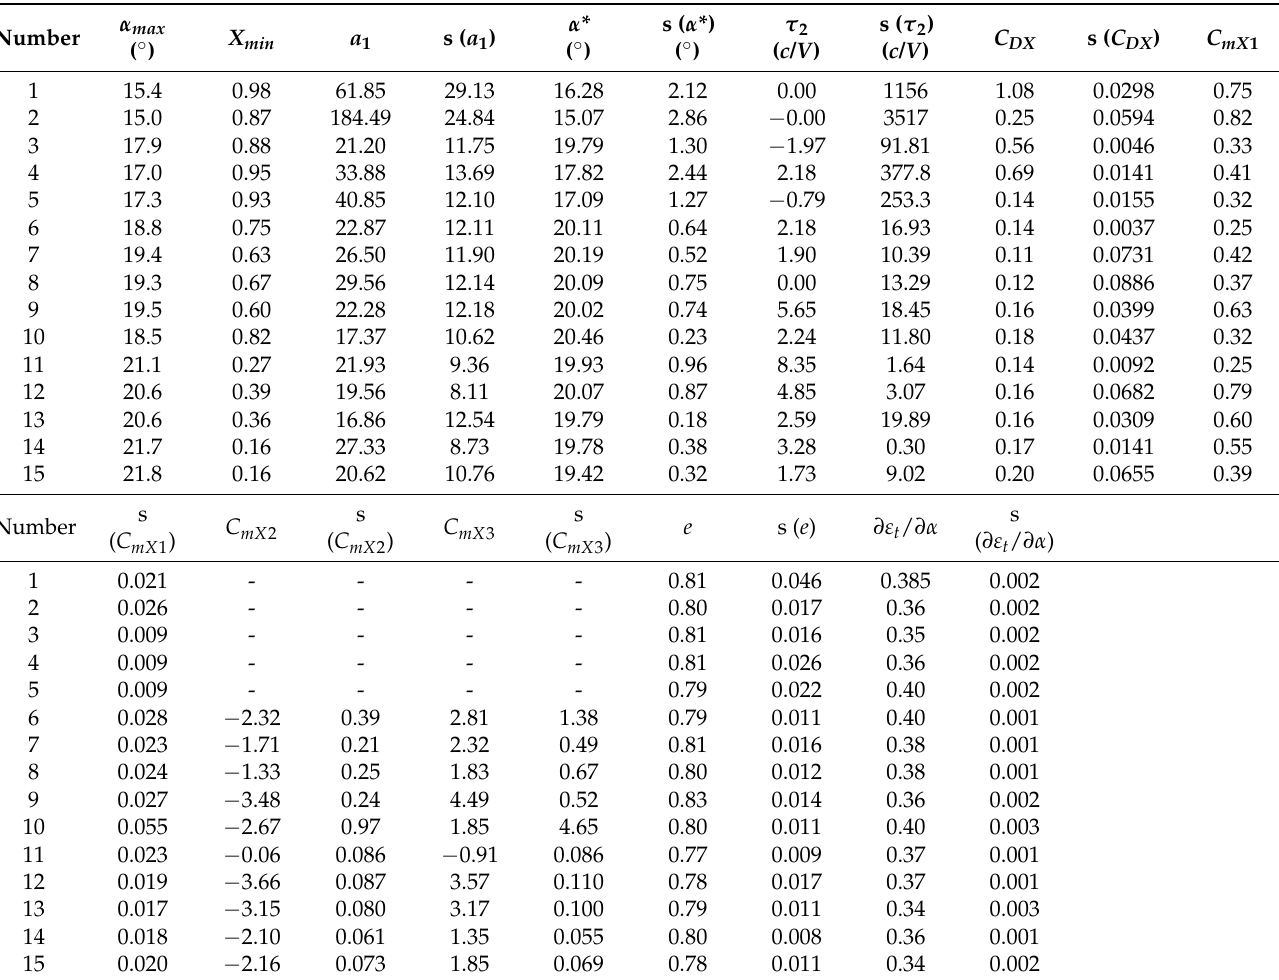
Table 1. Identification results of stall aerodynamic